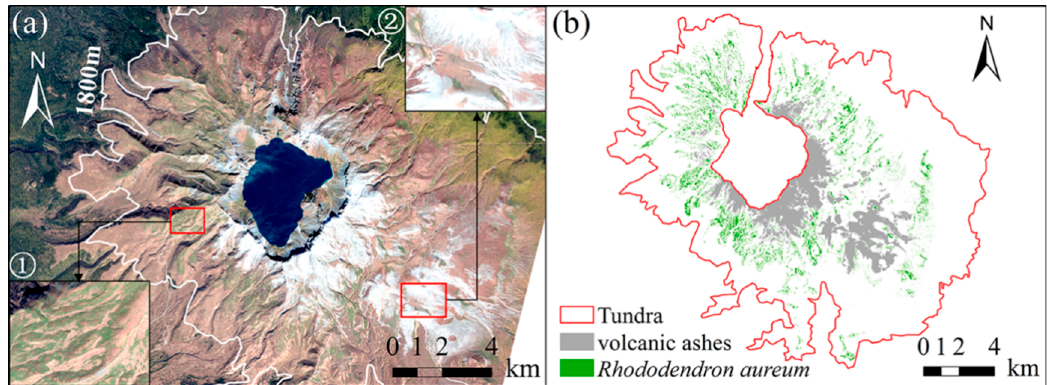
Figure 3. ( a ) GF-2 image of the study area during the senescence period (the green areas represent Rhododendron aureum in Subfigure ① , the white areas represent volcanic ashes in Subfigure ② ), ( b ) the distributions of R. aureum and volcanic ashes.